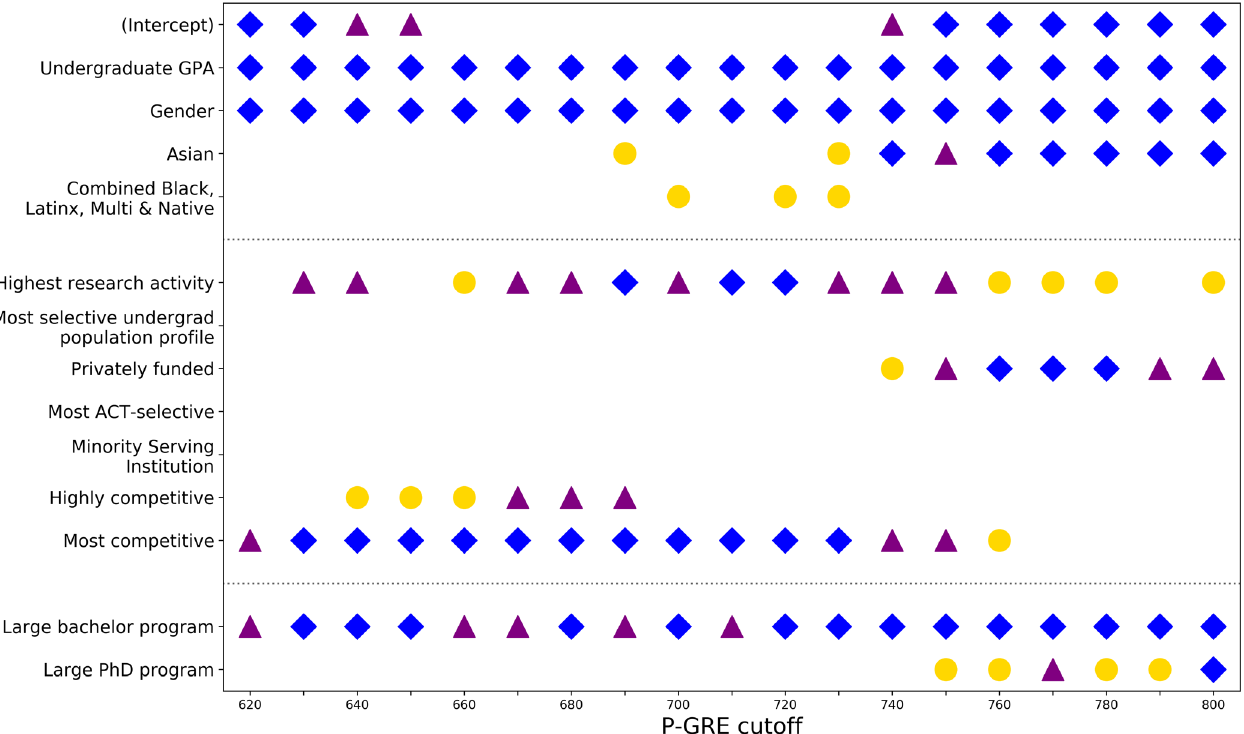
FIG. 3. Summary of odds ratio significance levels of 19 independent models: Each P-GRE cutoff score (horizontal coordinate) denotes an independent maximum graduates logistic regression model that includes possible duplicates (see Sec. III C). In each model, the fields of the statistically significant features are marked with a symbol indicating the Bonferroni-corrected significance level: circle indicates α ¼ 0 . 05 , triangle indicates α ¼ 0 . 01 , and diamond indicates α ¼ 0 . 001 . Blank fields indicate statistically insignificant results. The dotted separation lines categorize the features as applicant-related, institution-wide metrics and concerning Physics